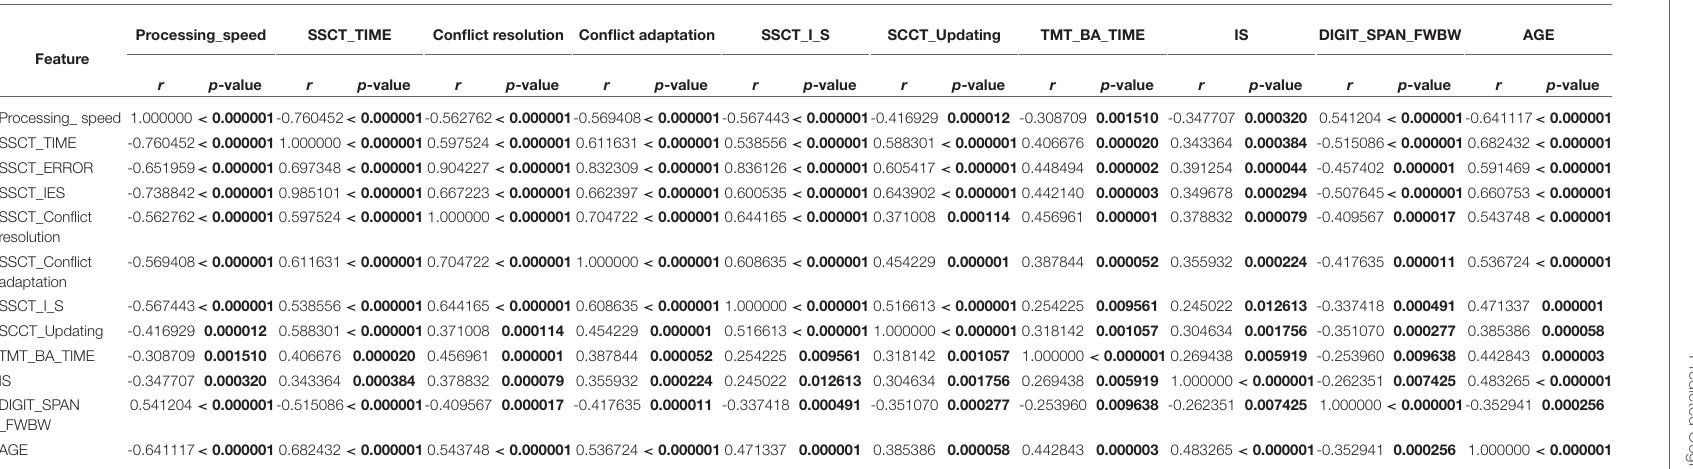
TABLE 2 | Correlation matrix of cognitive test performance and